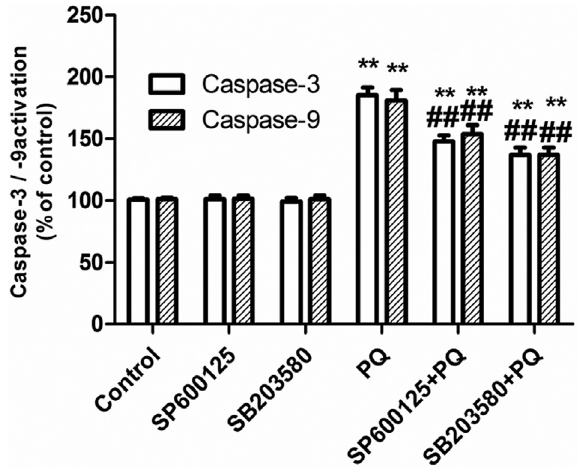
Figure 3 - Effect of blocking of MAPKs pathway on the activity of PQ in- duced Caspase-3/-9. ** P < 0.01 vs control group; ## P < 0.01 vs PQ alone